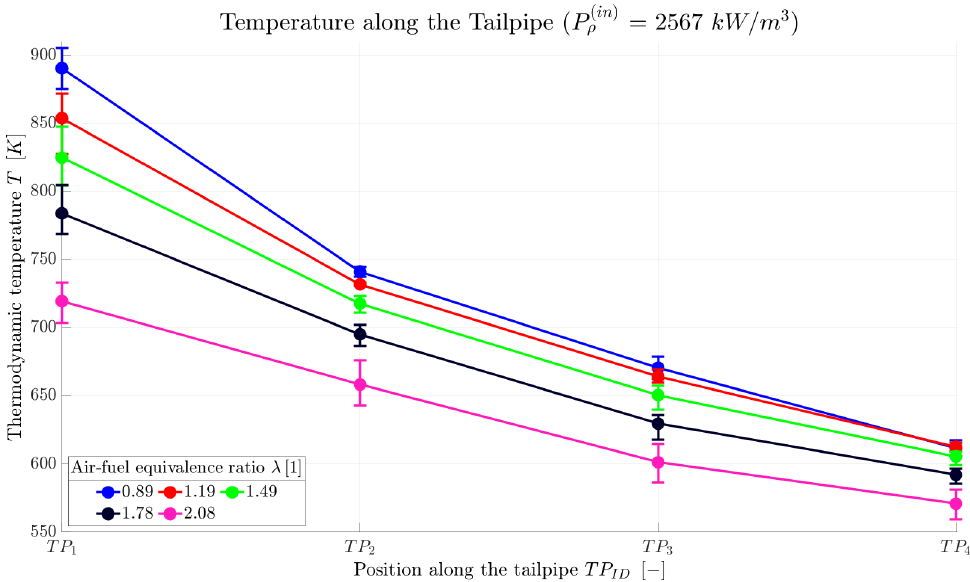
Figure 14. Temperature along the TP for one specific power density